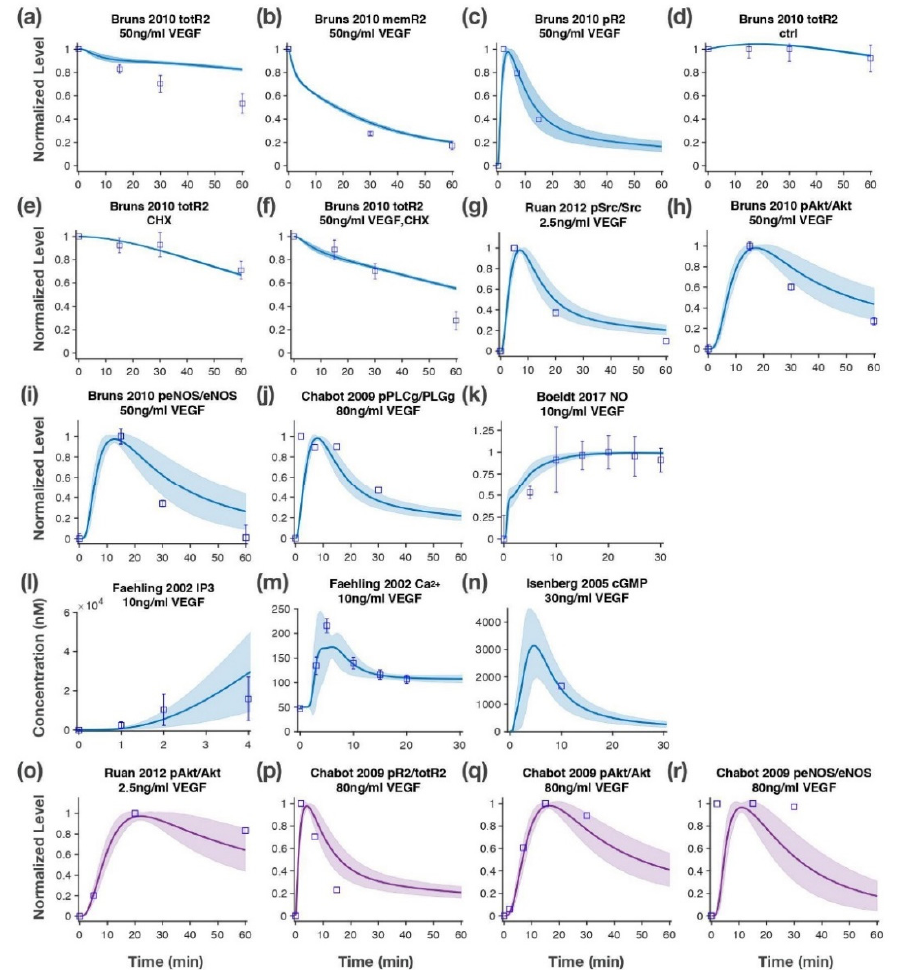
Figure 2. Model training and validation. The ODE model was trained to match in vitro experimental measurements of HUVECs for the activated species in the VEGF-mediated eNOS signaling pathway. Fitting results include model simulation compared to experimental datasets: ( a ) total R2 level; ( b ) membrane R2; ( c ) pR2 upon 50 ng/mL VEGF stimulation [67]; ( d ) total R2 in control condition [67]; ( e ) total R2 with cycloheximide treatment [67]; ( f ) total R2 with 50 ng/mL VEGF and cycloheximide treatment [67]; ( g ) pSrc with 2.5 ng/mL VEGF treatment [69]; ( h ) pAkt, ( i ) peNOS with 50 ng/mL VEGF treatment [67]; ( j ) pPLC γ with 80 ng/mL VEGF treatment [68]; ( k ) NO level with 10 ng/mL VEGF treatment [70]; concentration of ( l ) IP 3 and (m) cytosolic Ca 2+ with 10 ng/mL VEGF treatment [71]; ( n ) cGMP concentration with 30 ng/mL VEGF treatment [72]. ( o–r ) Several independent sets of data [68,69] were used to validate the model prediction. Solid line: mean of 19 best fits. Shaded area: standard deviation of 19 best fits. Squares: experimental data. Error bars: standard deviation of the experimental datasets. The normalized values are relative to the highest value for that species. ODE, ordinary differential equation; HUVECs, Human Umbilical Vascular Endothelial Cells; pR2, phosphorylated R2; pSrc, phosphorylated Src; pAkt, phosphorylated Akt; peNOS, phosphorylated eNOS; pPLC γ , phosphorylated PLC γ ; totR2, total R2; CHX, cycloheximide.